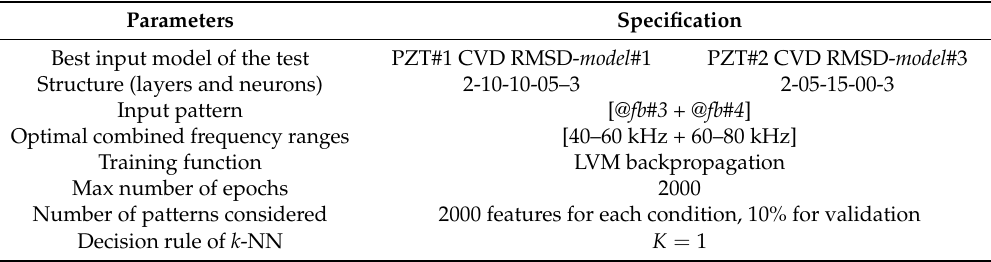
Table 4. Main characteristics of the best ANN models in experimental test case